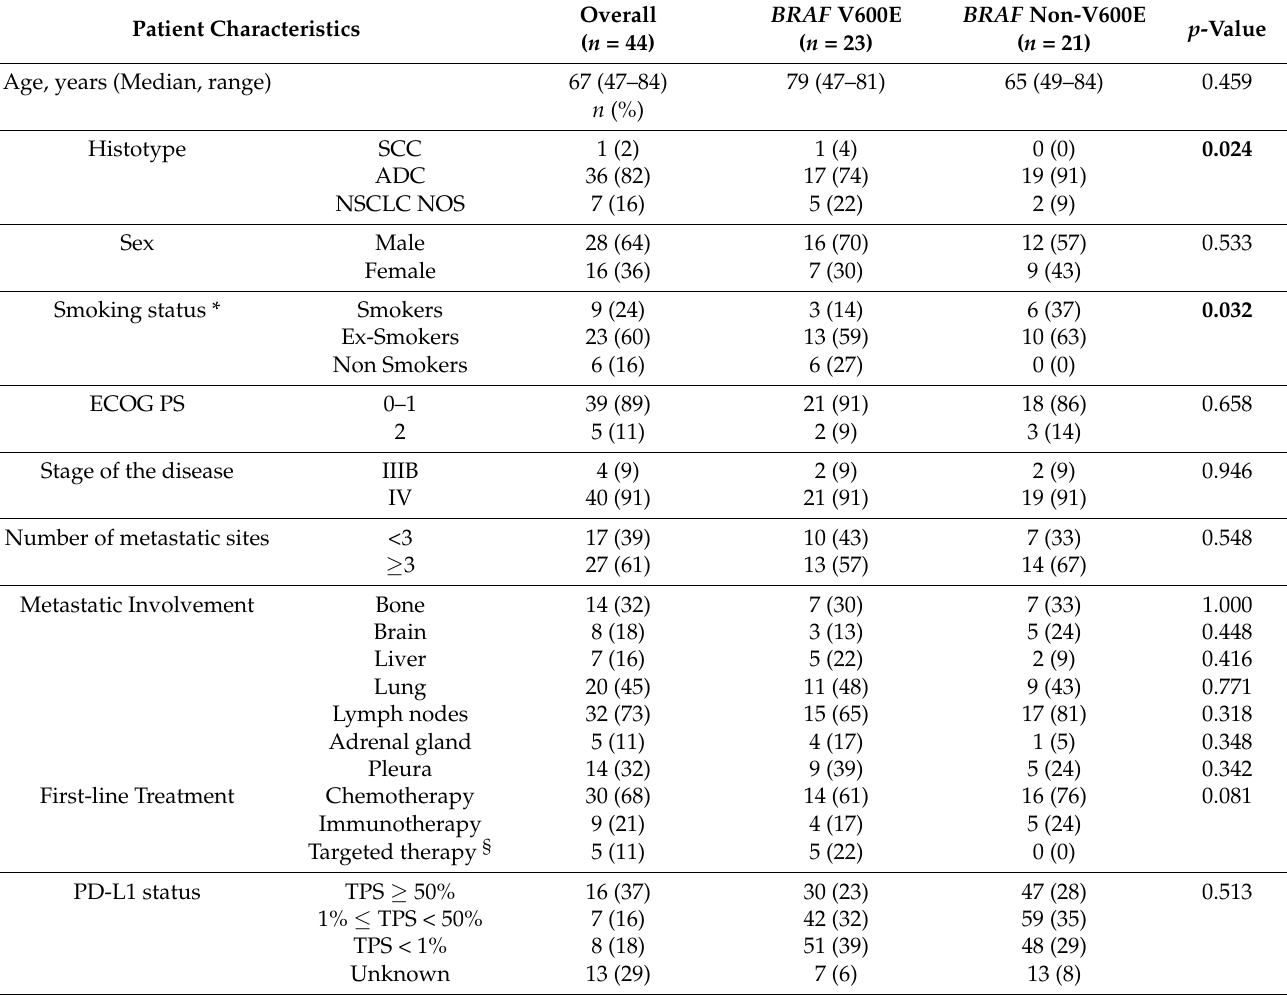
Table 1. Patient Population Characteristics. SCC: Squamous Cell Carcinoma; ADC: Adenocarcinoma; NSCLC: Non-Small Cell Lung Cancer; NOS: Not Otherwise Specified, ECOG: Eastern Cooperative Group; TPS: Tumor Proportional